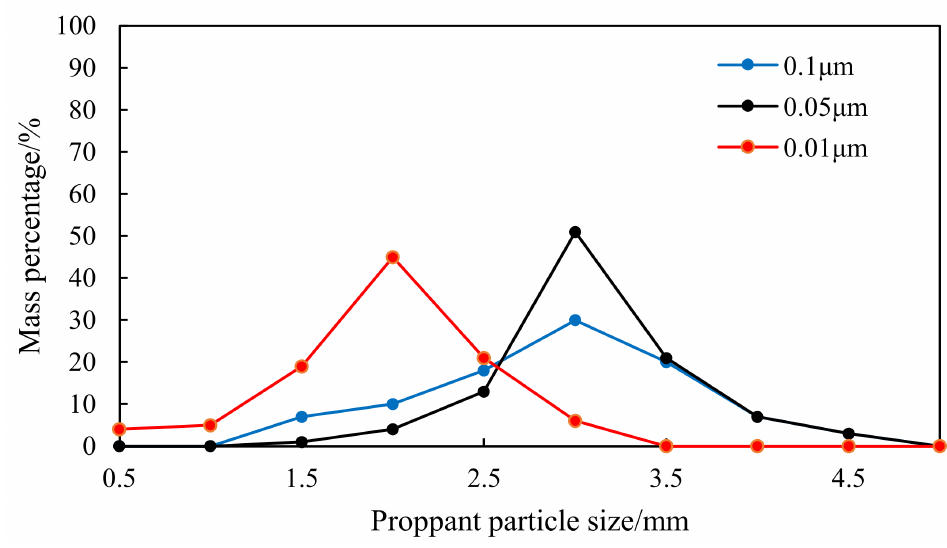
Figure 6. Particle size distribution of proppant obtained from different SiO 2 particles